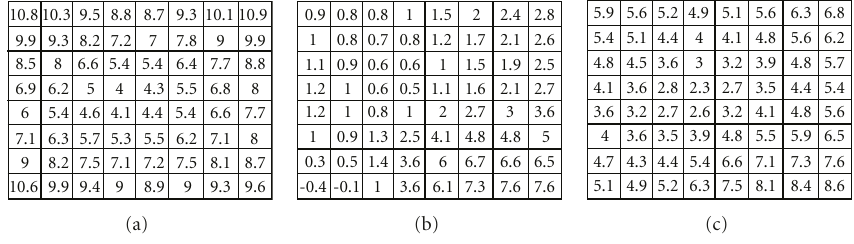
Figure 5: For data matrix of Figure 1(a): (a) upper envelope matrix using BEMD with thin-plate spline interpolation, (b) lower envelope matrix using BEMD with thin-plate spline interpolation, and (c) mean envelope matrix obtained by averaging the data in (a) and (b).